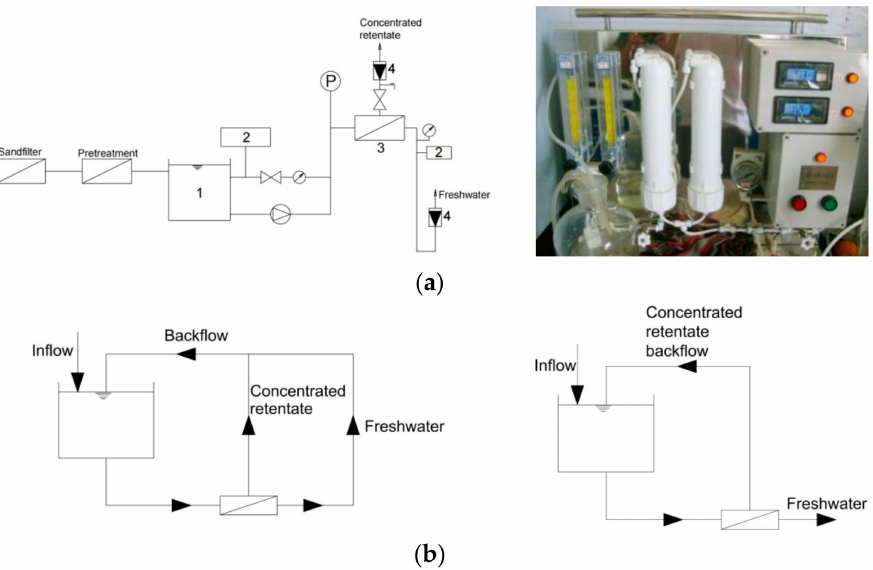
Figure 1. The scheme of pilot-scale UF process. ( a ) UF process and the photo of UF modules; 1: Tank, 2: Conductivity meter, 3: UF module, 4: Flowmeter. ( b ) Varied operating